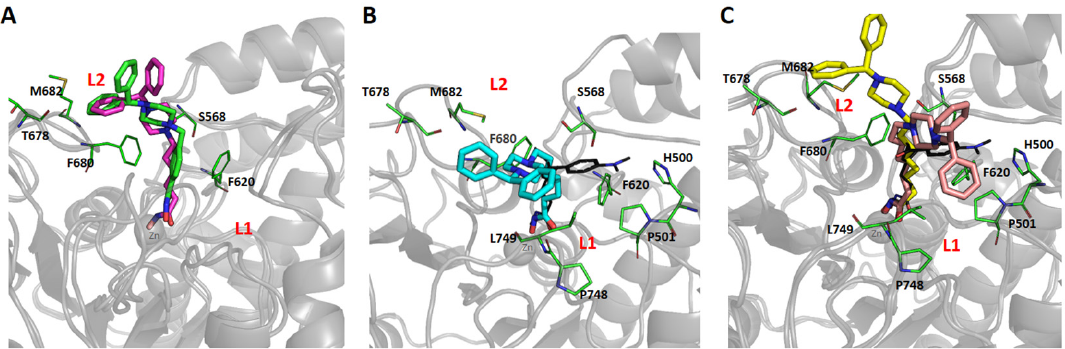
Figure 3. Predicted binding modes of superimposed 6b (green sticks, ( A )) and 9b (magenta sticks, ( A )), 7b (cyan sticks, ( B )), and 8b (yellow and salmon sticks, ( C )) in complex with CD2 HDAC6. Interacting amino acid residues from L1 and L2 pockets are represented by green sticks; the co-crystal TSA ligand is presented as black lines.